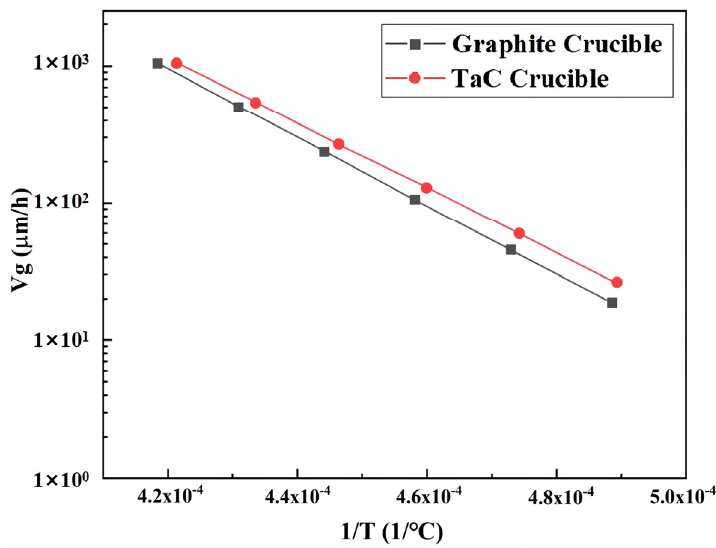
Figure 3. Growth rates of the AlN crystal grown in different crucibles.